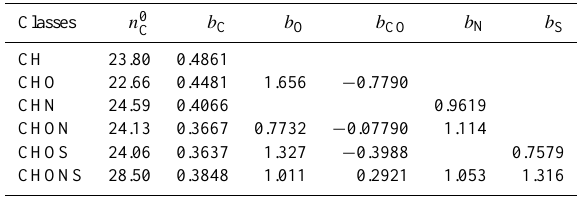
Table 1. Composition classes and the n 0 mass concentration parameterizations obtained by least-squares op- timization using the NCI